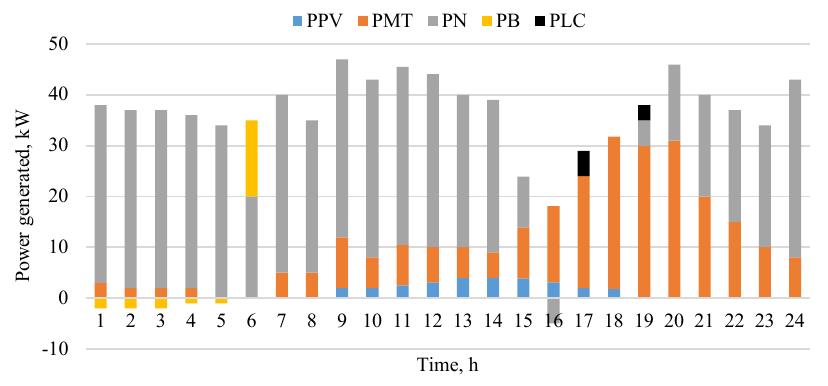
Fig. 7. Output power of each components and network in scenario 3.